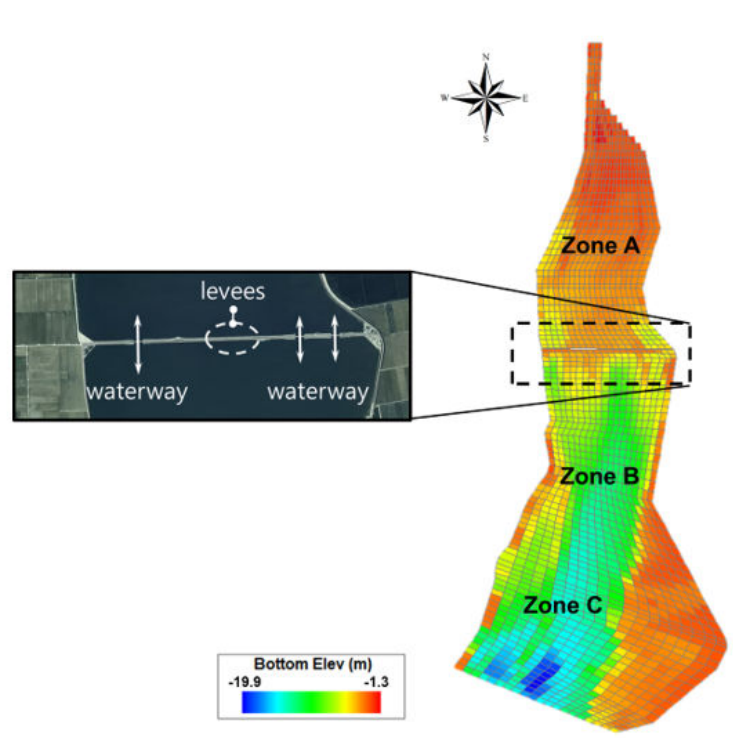
Figure 3. Bottom elevation and levees of the estuarine reservoir in EFDC model.